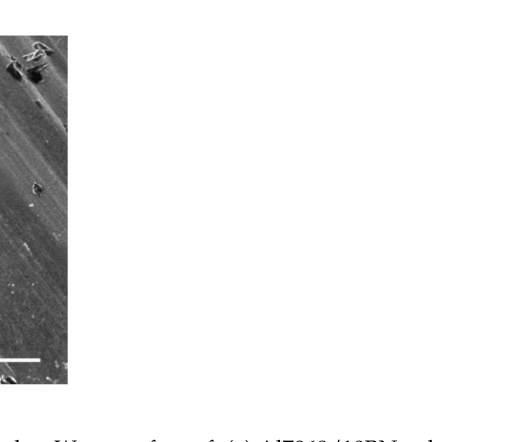
Figure 6. SEM micrograph of AMMC samples. Worn surface of: ( a ) Al7068/10BN at lower magni- fication; ( b ) Al7068/10BN at higher magnification; ( c ) Al7068/10Si 3 N 4 ; ( d ) Al7068/10Si 3 N 4 /5BN; ( e ) Al7068/10Si 3 N 4